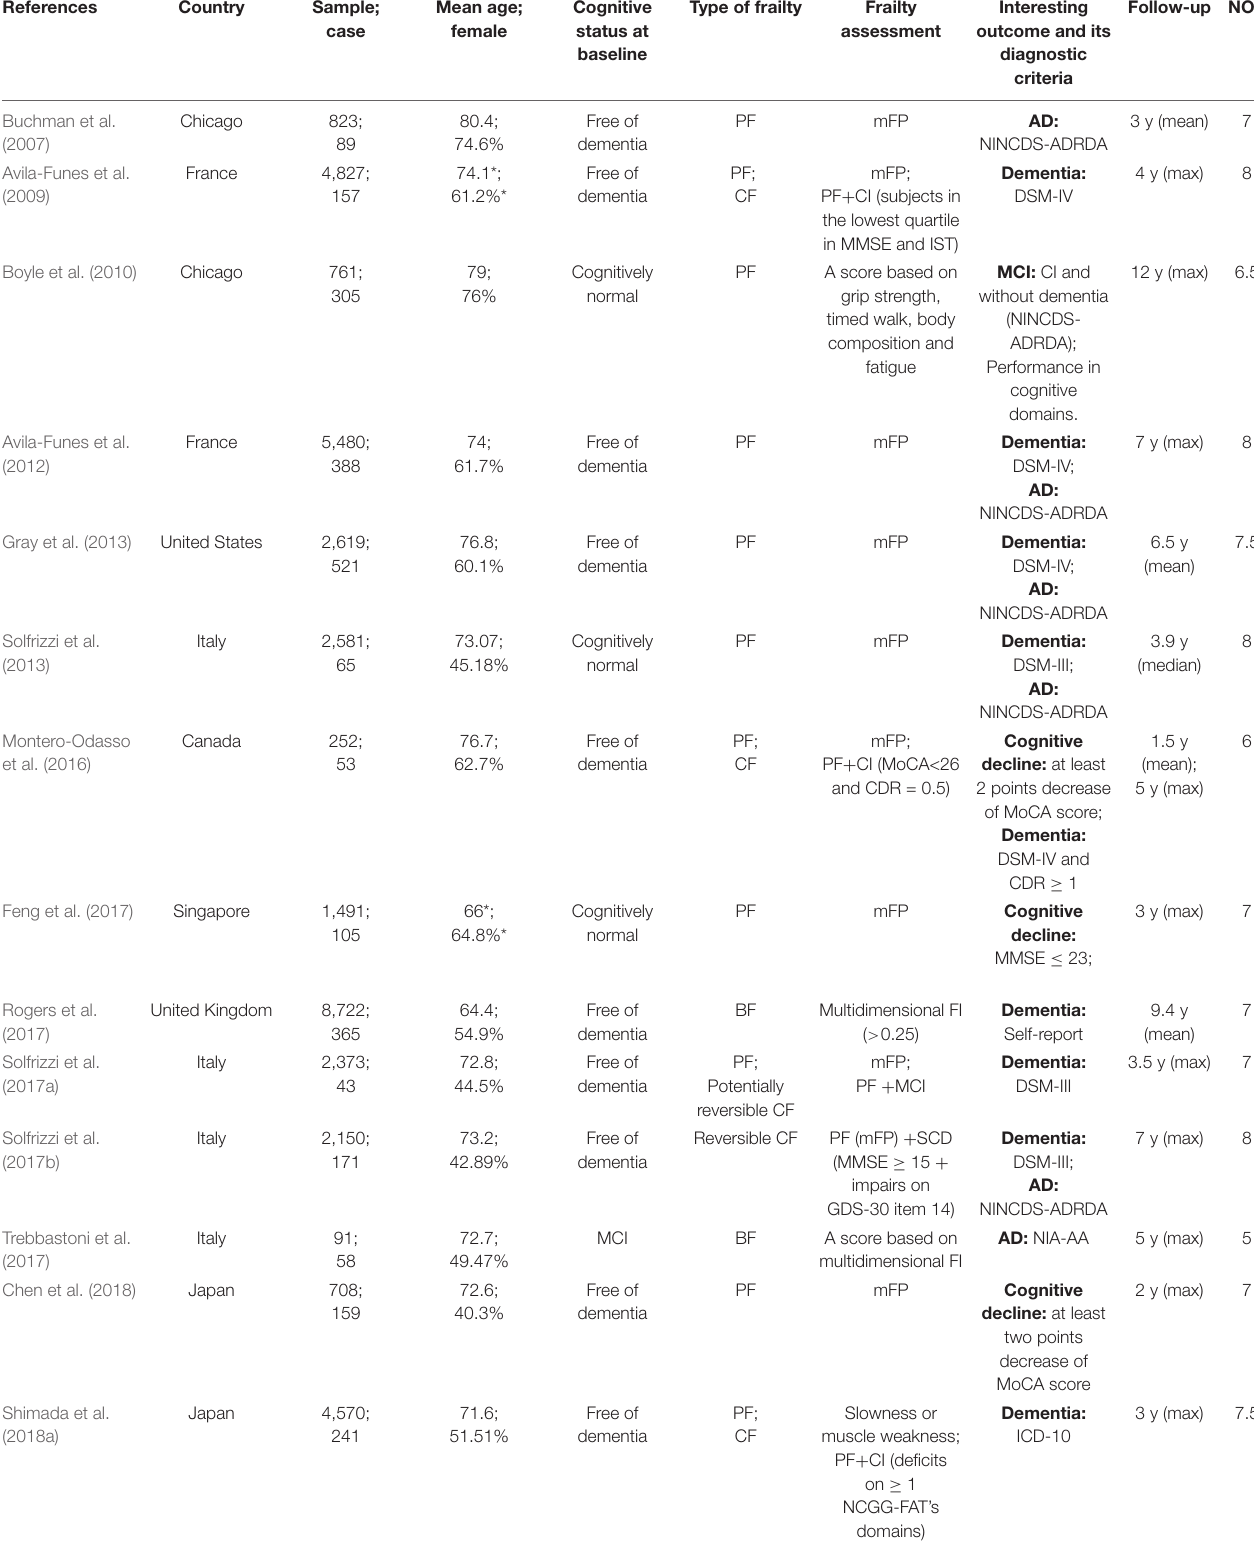
TABLE 1 | Characteristics of included